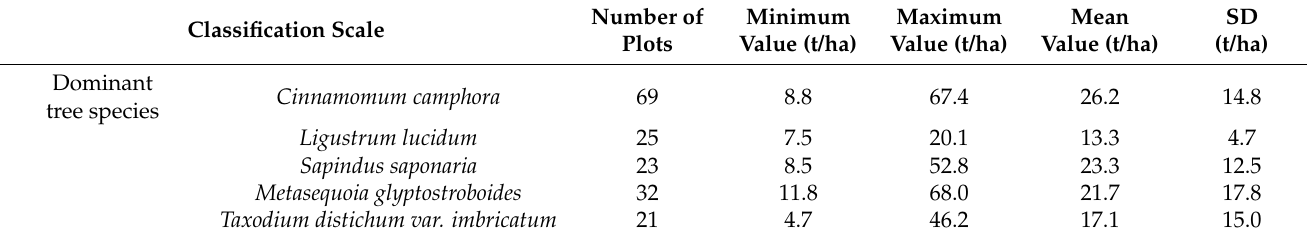
Table 1. Summary of the variability of the carbon densities (t/ha) of the 308 plots. Classification